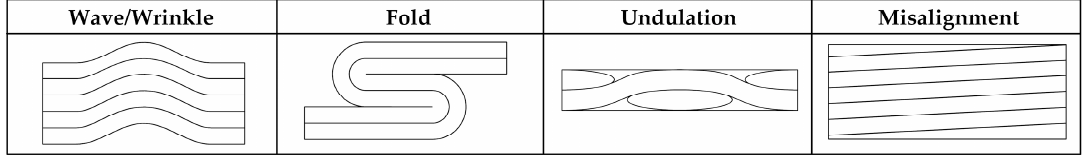
Figure 1. General definition of deviations from the intended fiber orientation (i.e., wave/wrinkle, fold, undulation, and misalignment).